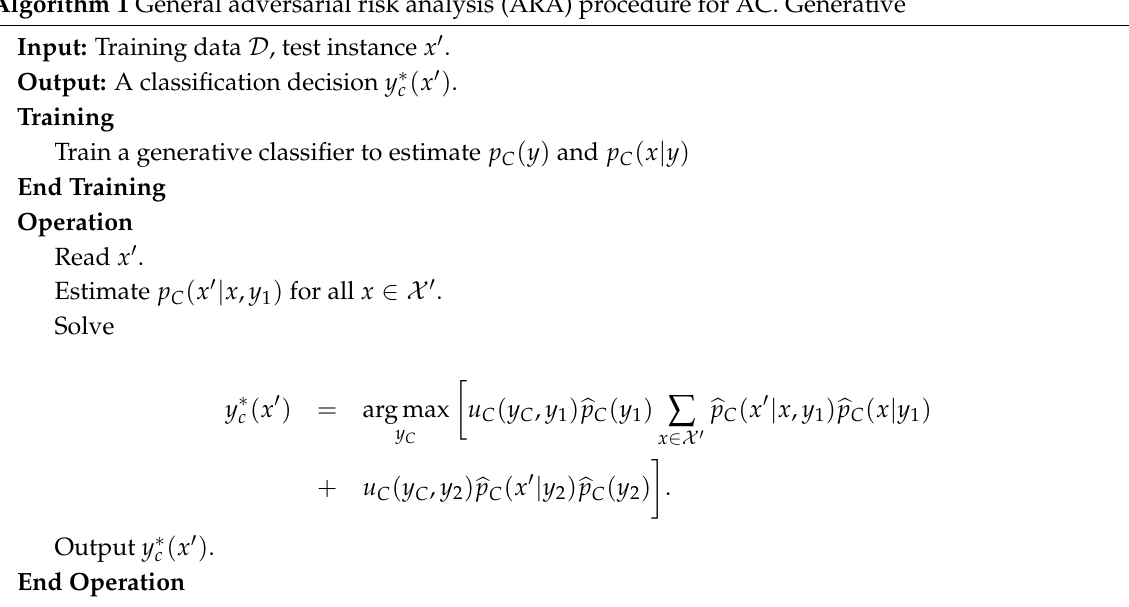
Algorithm 1 General adversarial risk analysis (ARA) procedure for AC.